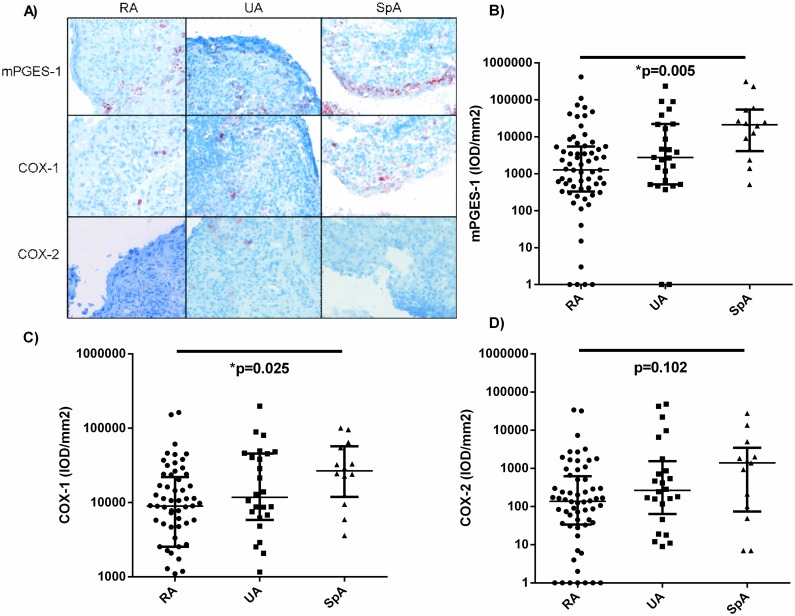
Baseline synovial expression of PGE2 pathway enzymes of early arthritis patients classified as RA, UA and SpA at 2 years follow-up.Representative immunohistochemical staining (A), Expression of mPGES-1 (B) and COX-1 (C) is increased in SpA patients. D) A trend towards increased expression of COX-2 is observed in SpA patients; values expressed as median (IQR) on a logaritmic scale; RA: rheumatoid arthritis; UA: unclassified arthritis; SpA: spondyloarthritis; mPGES-1: microsomal prostaglandin E synthase-1; COX: cyclooxygenase; IOD: integrated optical density.